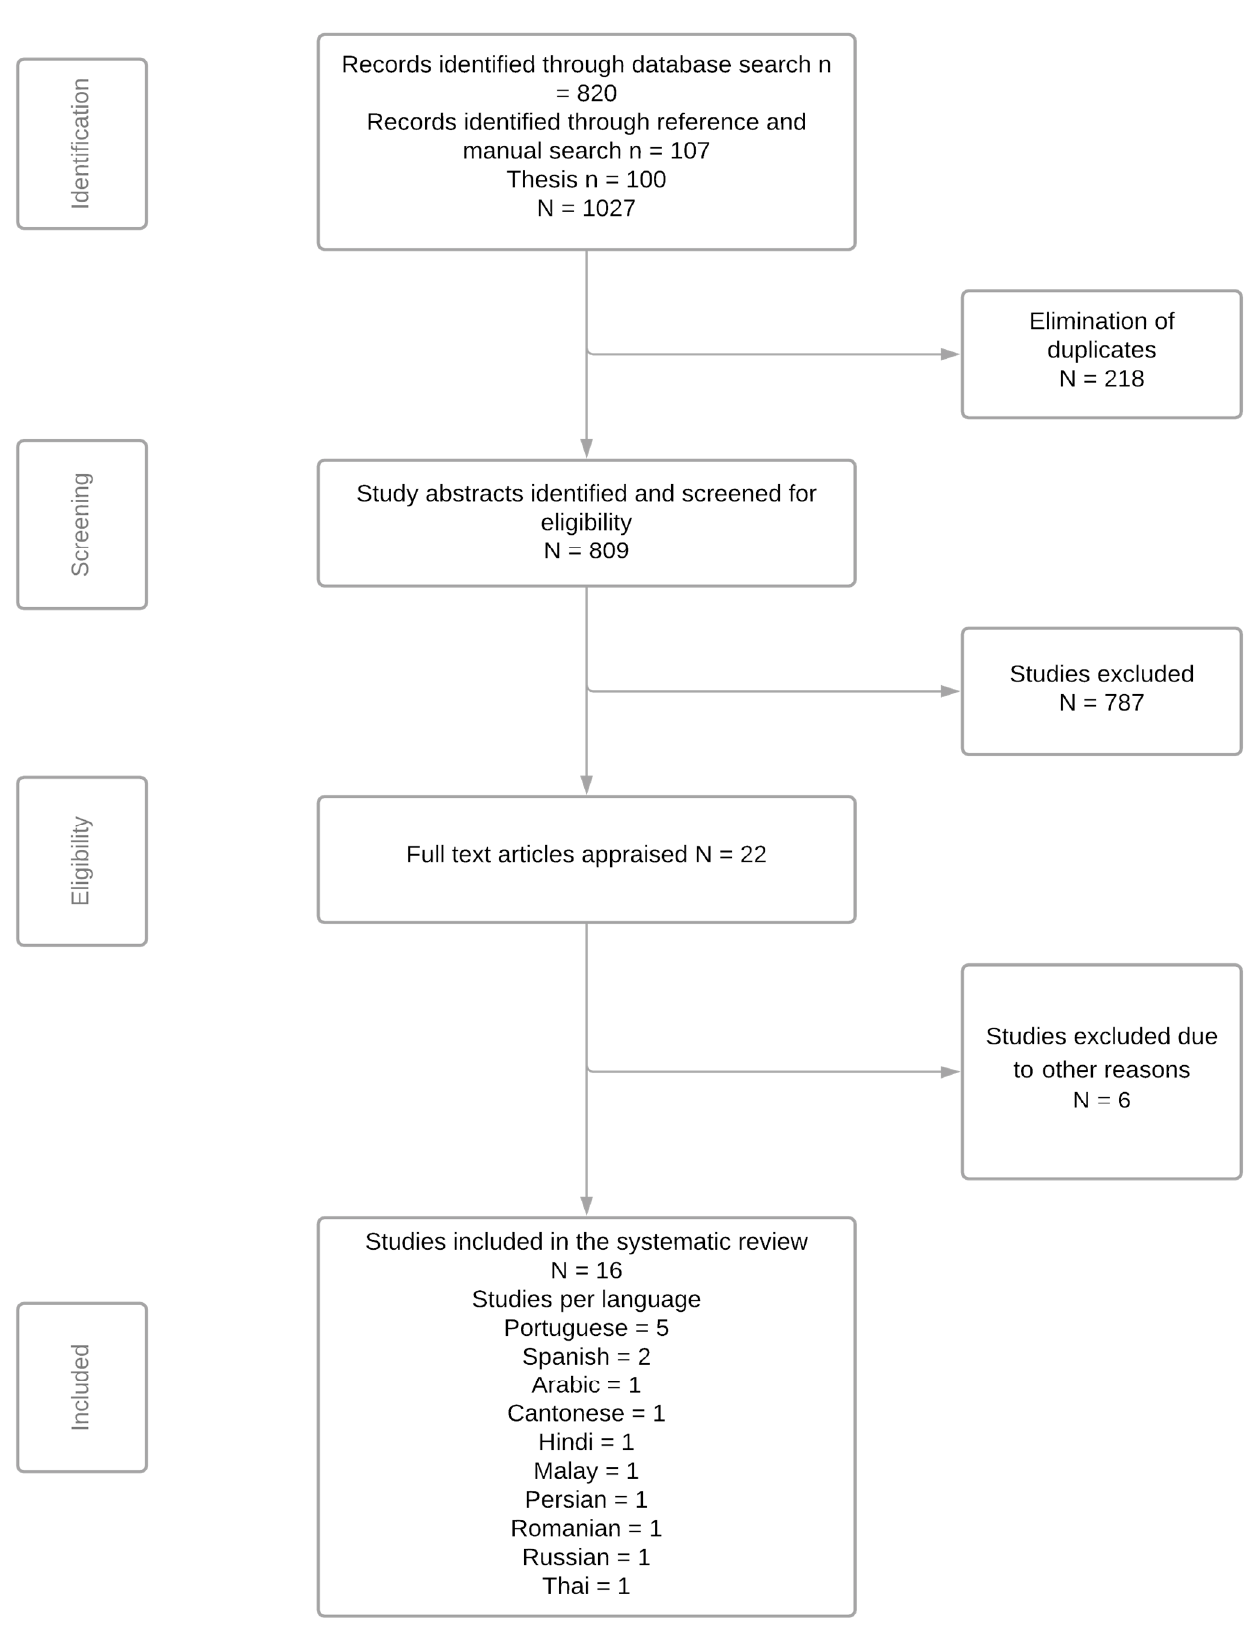
Figure 1. PRISMA flow